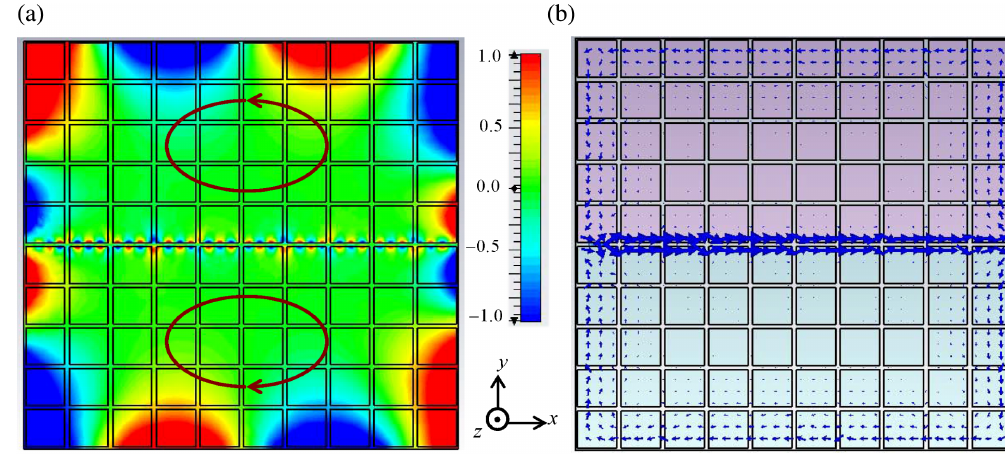
FIG. 5. Similar to Fig. 4 but for a horizontal (along þ x ) electric